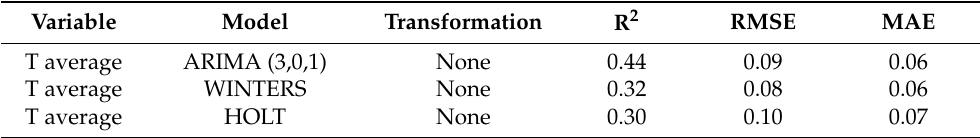
Table 5. Annual average temperature, models, and adjustment statistics.